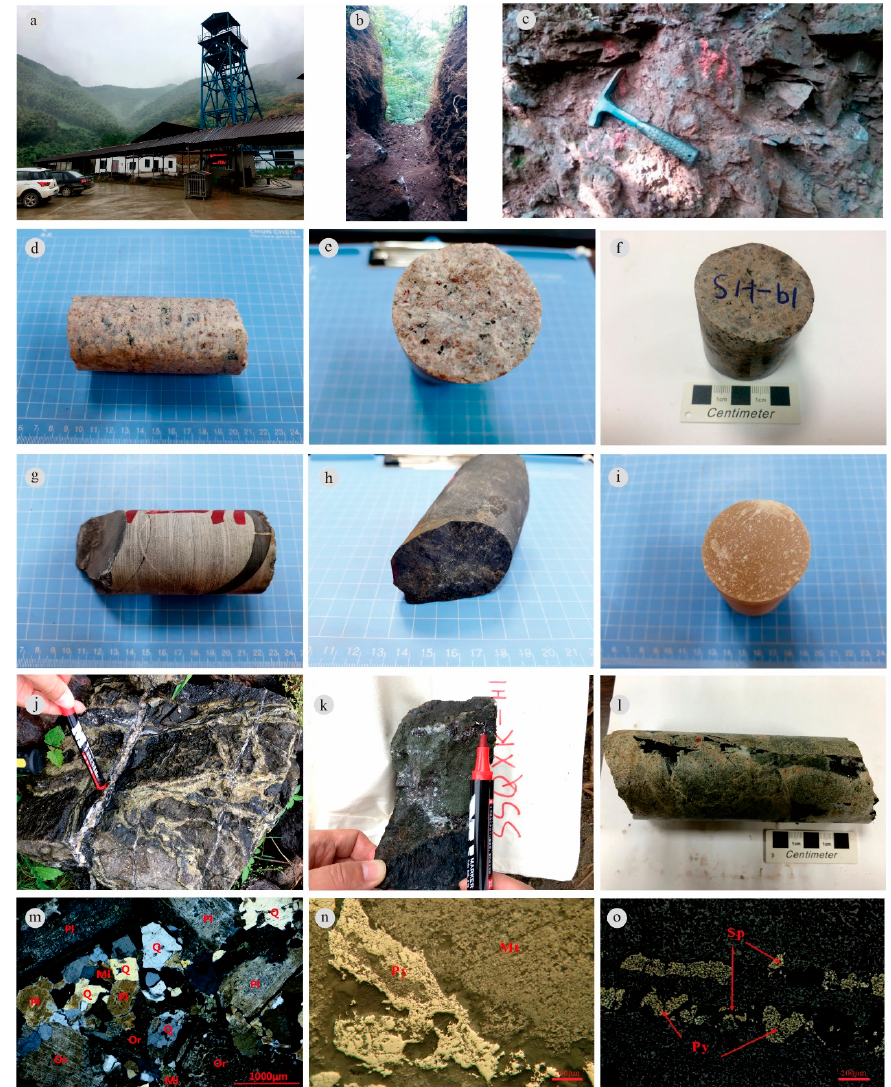
Figure 17. Photos of typical A-type granites and related ores in the FVB. ( a ) Xiaoyangchong mining area; ( b ) trench in Suishan mining area; ( c ) outcrop of hematitization skarn; ( d – e ) typical A-type granite in Taochong mining area; ( f ) typical A-type granite in Suishan mining area; ( g – i ) cores of main ore-bearing strata: g-banded limestone, h-siltstone, and i-anhydrite; ( j – l ) main ore types re- lated to A-type granite: j-Xiaoyangchong skarn magnetite ore; k-Suishan hydrothermal magnetite-sphalerite ore; l-Suishan garnet skarn; ( m ) microphotograph (crossed nicols) of typical A-type granite; ( n ) reflected light photograph of magnetite ore; ( o ) reflected light photograph of pyrite–sphalerite ore. The Harker diagram and trace element covariant diagram are used to investigate the magmatic evolution process. As can be seen from Figure 5, the intrusive rocks in the FVB are similar to other A-type granites in the MLYMB, and fractional crystallization plays a dominant role in the magmatic evolution process. According to the Harker diagram (Figure 6), SiO 2 content is negatively correlated with Fe 2 O3 T , MgO, P 2 O 5 , and TiO 2 con- tent, indicating the separation and crystallization of Fe-bearing mafic minerals (pyroxene, amphibole, and biotite), apatite, and titanite. The negative correlation with Al 2 O 3 , CaO, and Eu/Eu* indicates the crystallization of